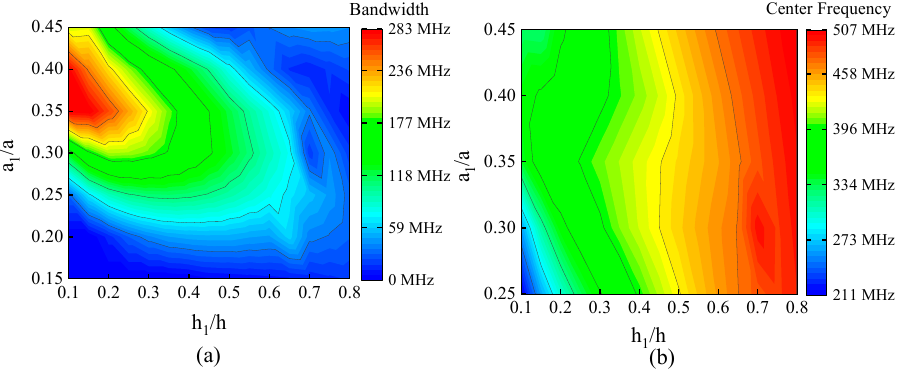
Figure 5. The influence of geometric parameters on ultra-wideband gap. ( a ) the influence of geometric parameter ratio ( ℎ 1 /ℎ , 𝑎 1 /𝑎 ) on bandwidth; ( b ) the influence of geometric parameter ratio ( ℎ 1 /ℎ , 𝑎 1 /𝑎 ) on center frequency.